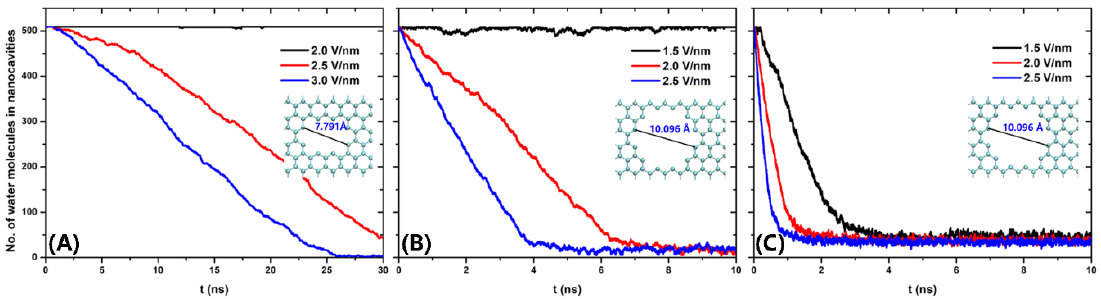
Figure 4. The numbers of water molecules between the graphene walls during the simulations for the cases of Pore-I ( A ), Pore-II ( B ), and Pore-III ( C ), respectively.